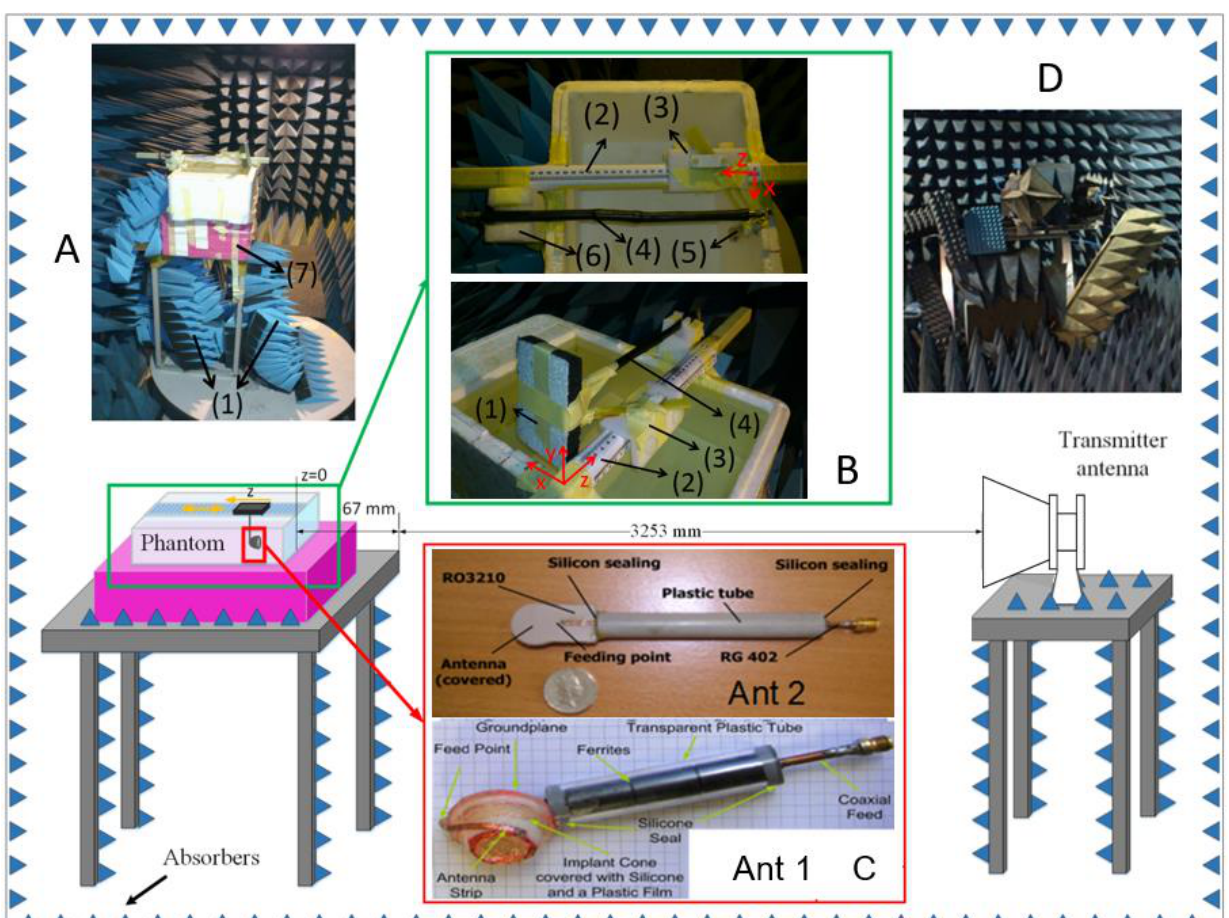
Figure 3. Setup used in Queen Mary University of London’s anechoic chamber for the characterization of plane wave attenuation. ( A , B ) Test bed of the phantom with a probe antenna inside. (1) Absorbing panels, (2) ruler, (3) structure for moving the antenna, (4) feeding cable with ferrite-based absorbing material, (5) antenna, (6) backside foam structure, (7) polystyrene box to ensure that the transmitter antenna and the implanted antenna are at the same height. ( C ) The two implanted broadband antennas employed to cover the desired frequency ranges. ( D ) The transmitting horn antenna.